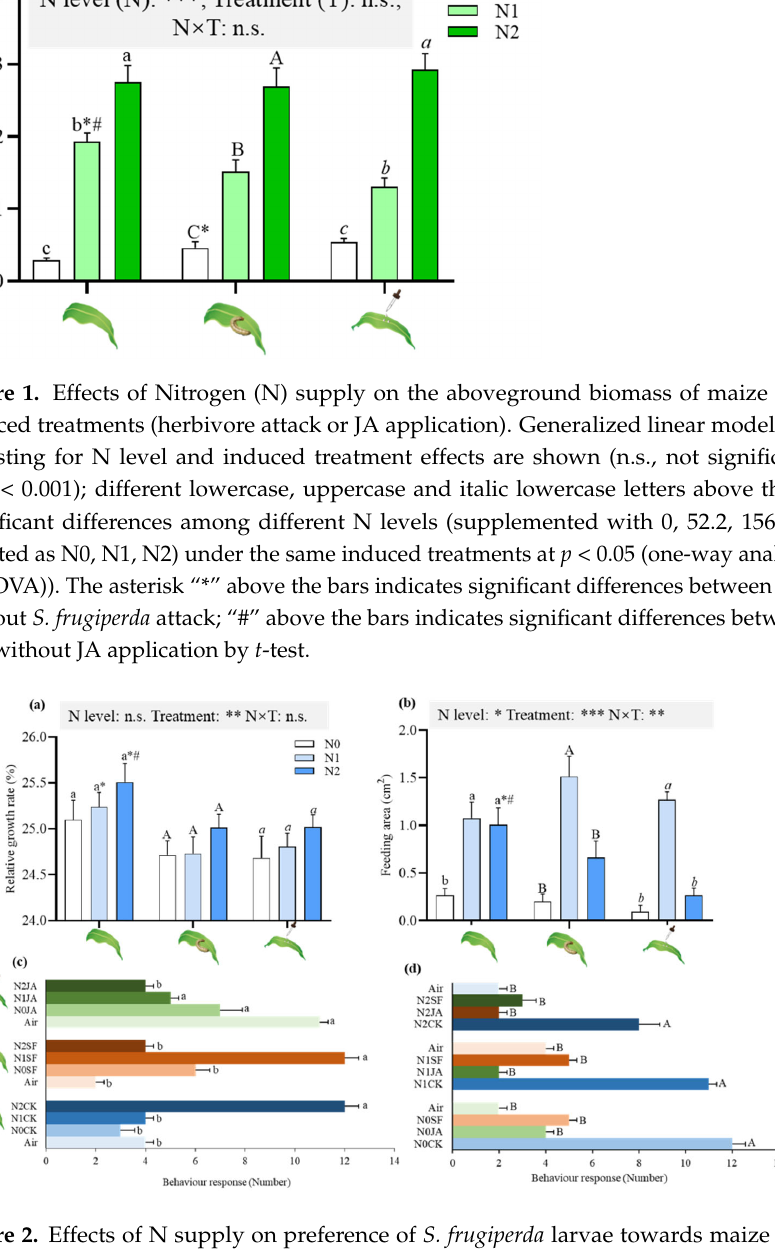
Figure 2. Effects of N supply on preference of S. frugiperda larvae towards maize under different induced treatments. ( a ) Relative growth rate (RGR) of S. frugiperda larvae; ( b ) feeding leaf area (cm 2 ) by S. frugiperda larvae; ( c ) behavioral response (number) of S. frugiperda towards maize plants from different N levels under the same induced treatments; ( d ) behavioral response (number) of S. frugiperda towards maize plants from different induced treatments under the same N levels. GLM results of testing for N level and induced treatment effects are shown (n.s., not significant; * p < 0.05; ** p < 0.01; *** p < 0.001); different lowercase, uppercase and italic lowercase letters above the bars indicate significant differences among different N levels under the same induced treatments. The asterisk “*” above the bars indicates significant differences between maize with and without S. frugiperda attack; “#” above the bars indicates significant differences between maize with and without JA